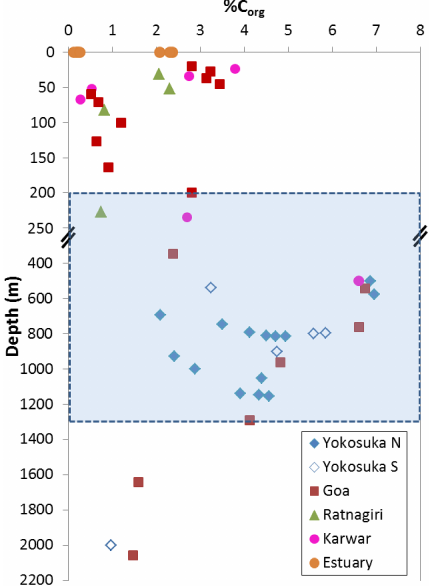
Figure 3. Organic carbon weight percentage (%C org ) in surficial sediments (0–2cm) from estuary, shelf and upper slope sites on the Indian margin of the Arabian Sea. Shaded area indicates approxi- mate depth of permanent mid-depth OMZ (< ∼